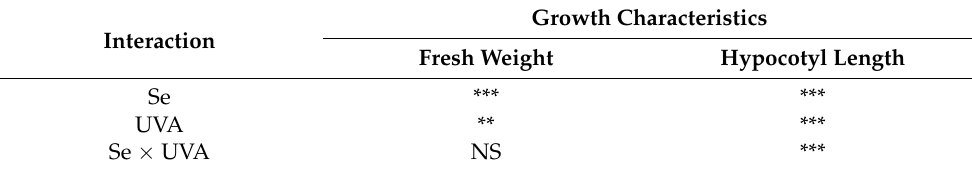
Table 1. The interaction effects of Se and UVA on growth characteristics of broccoli